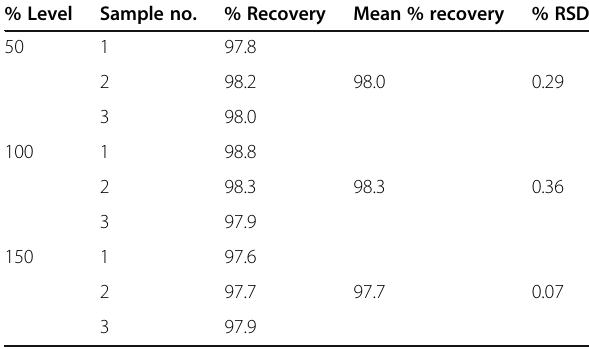
Table 5 Result of accuracy study